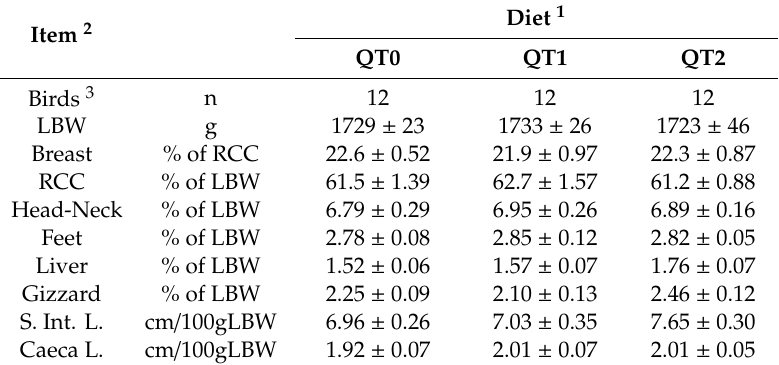
Table 2. Major body parts and internal organs evaluation of birds fed di ff erent levels of QT from 35 to 175 days old (mean ±